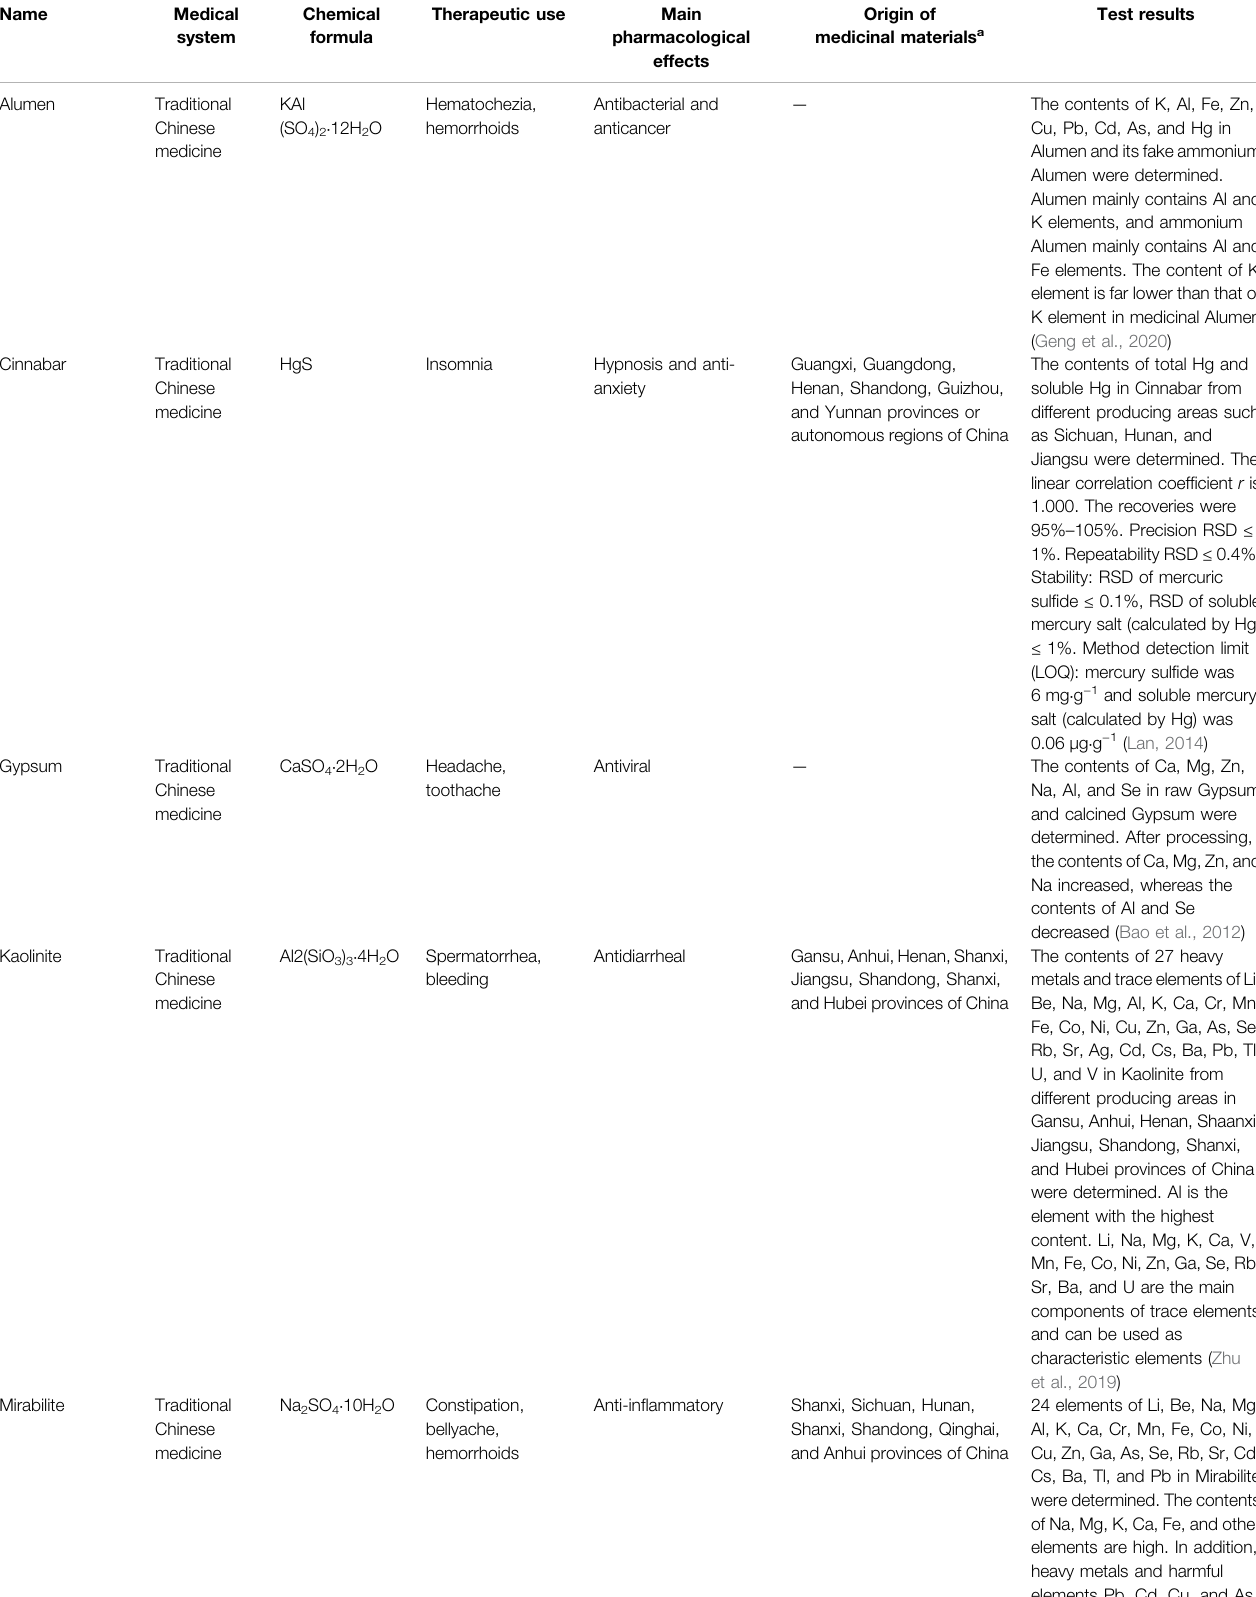
TABLE 9 | Application of ICP-MS in the determination of heavy metal elements in medicinal materials derived from minerals.